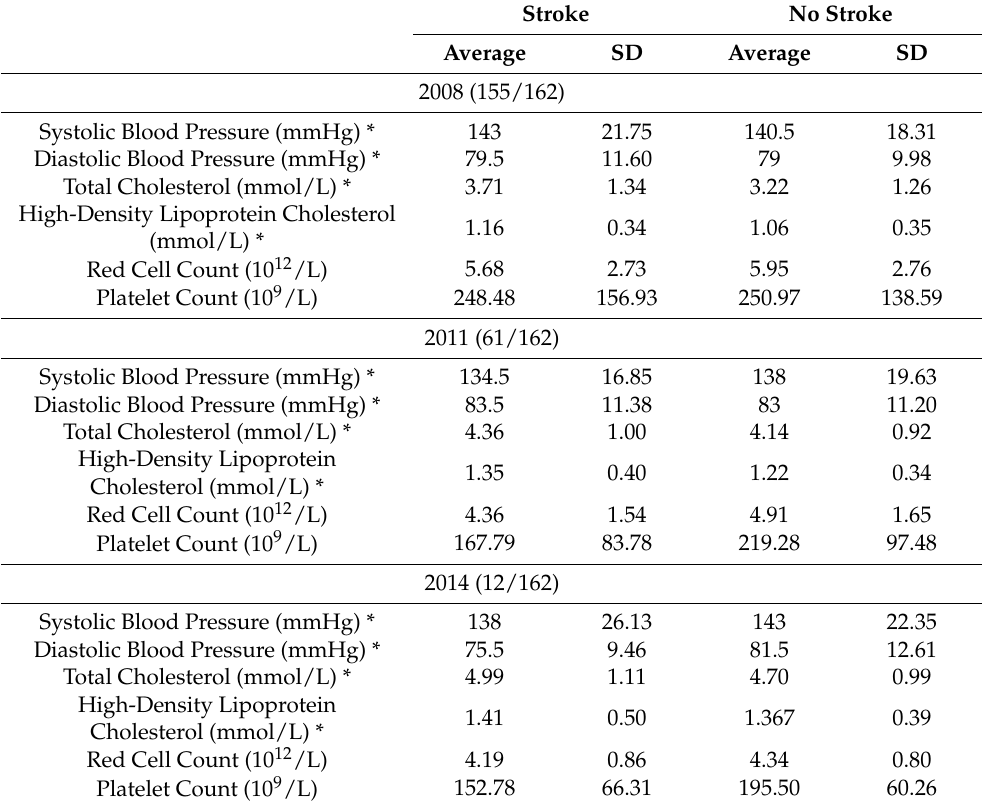
Table 1. Average and standard deviation of six main numerical risk factors at each measurement for stroke and no-stroke